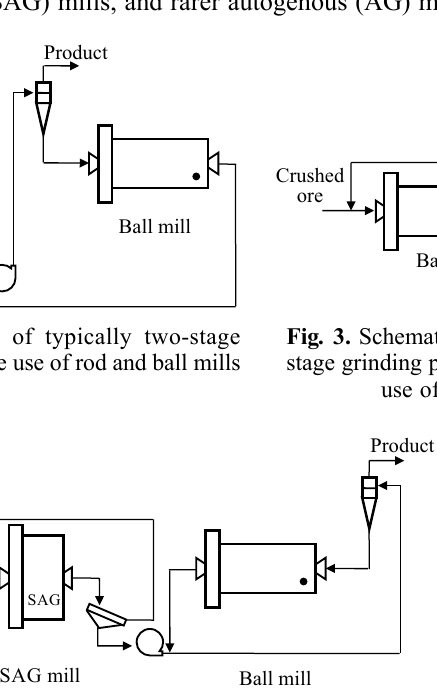
Fig . 4. Schematic overview of two-stage grinding process, based on the use of SAG and ball mills